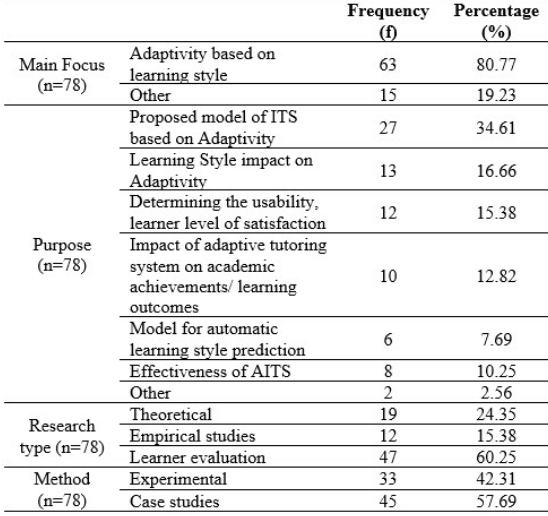
Table 1. Summary of main focus, pur- pose, research type, and method for the inves- tigated